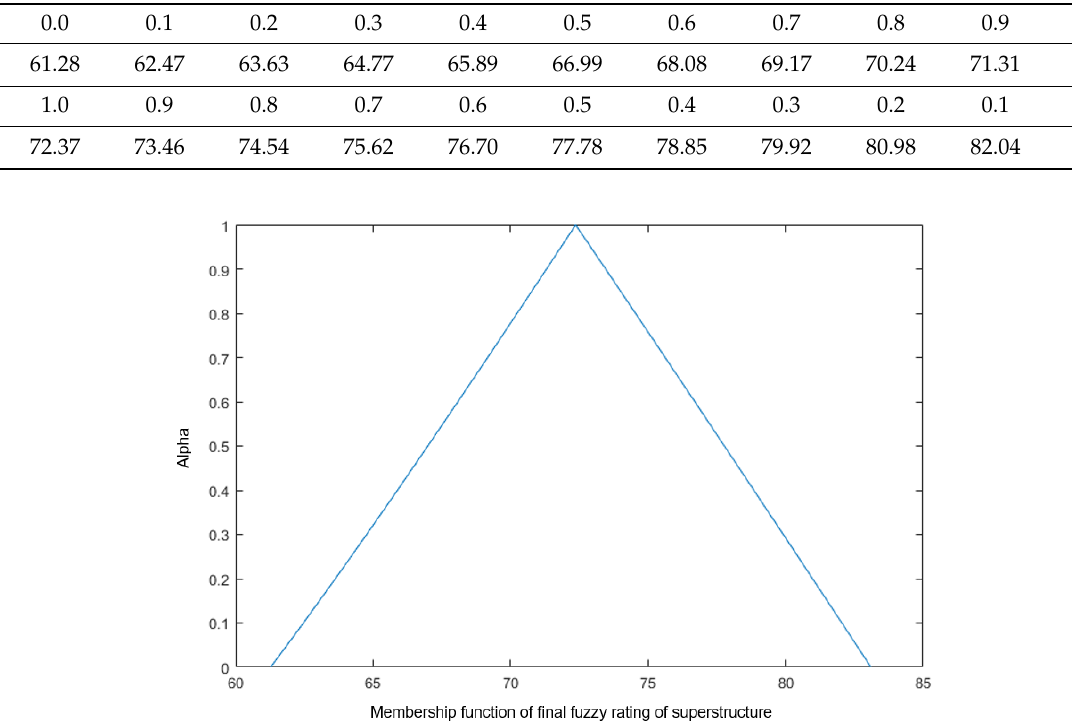
24 of 44 Figure 6. Graphical representation of the superstructure component rating values for all combina- tions. After defining the fuzzy ratings of the superstructure component by all combina-